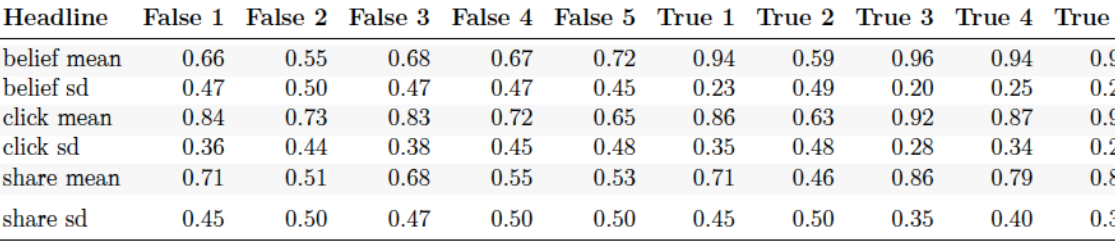
Table D2. Distributions of outcomes for each